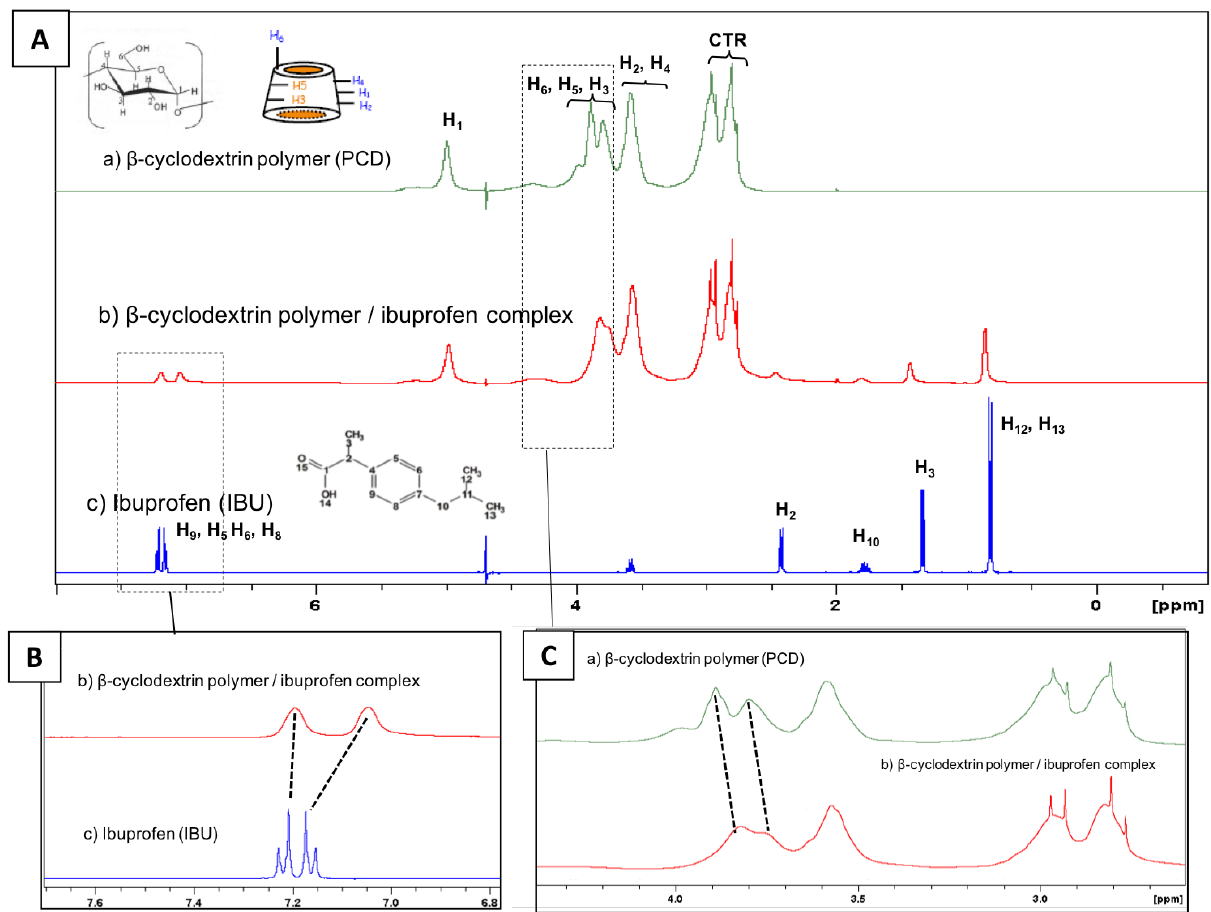
Figure 3. ( A ) Full scale 1 H NMR in D 2 O of (a) β-cyclodextrin polymer (PCD); (b) β-cyclodextrin polymer/ibuprofen complex and (c) ibuprofen (IBU). ( B ) Magnifications focusing on the signals of aromatic protons of IBU and ( C ) on the signals of PCD protons.